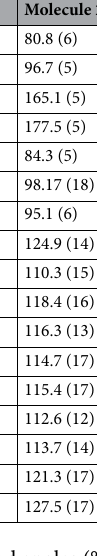
Table 4. Selected bond angles